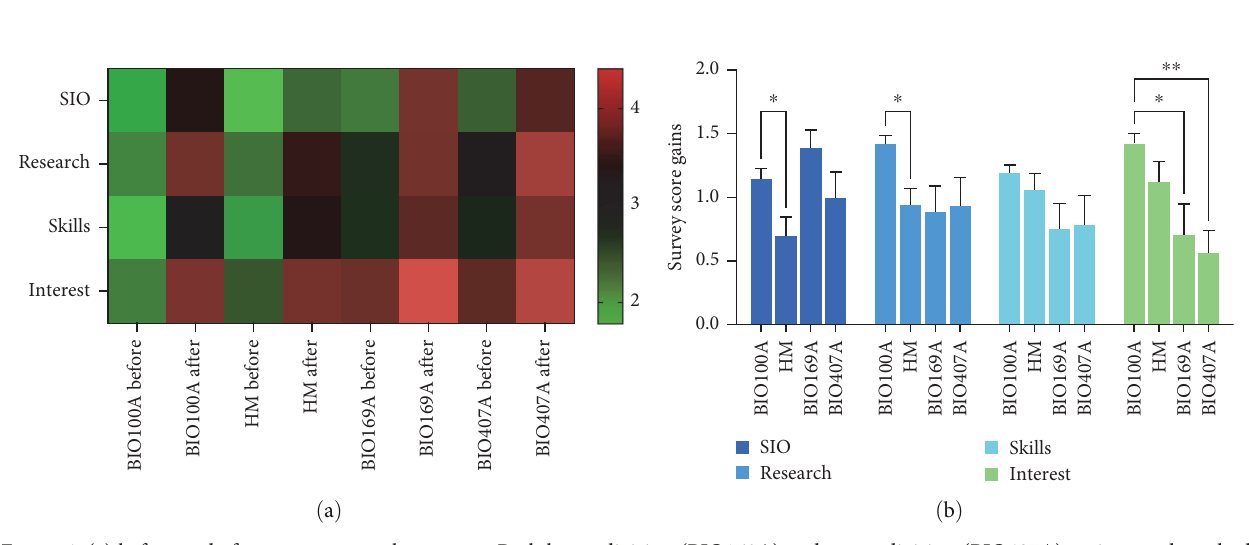
F IGURE 4: (a) before and after survey scores by courses. Both lower division (BIO169A) and upper division (BIO407A) majors students had higher before scores compared to non-majors and health majors. (b) Survey score gains by courses. Nonmajors had signi fi cantly higher gains compared to health majors for both SIO ( p ¼ 0 : 033) and Research ( p ¼ 0 : 0207), and signi fi cantly higher gains for Interest compared to both lower division ( p ¼ 0 : 0437) and upper division ( p ¼ 0 : 0012) majors. ∗ p ≤ 0 : 05 and ∗∗ p ≤ 0 :